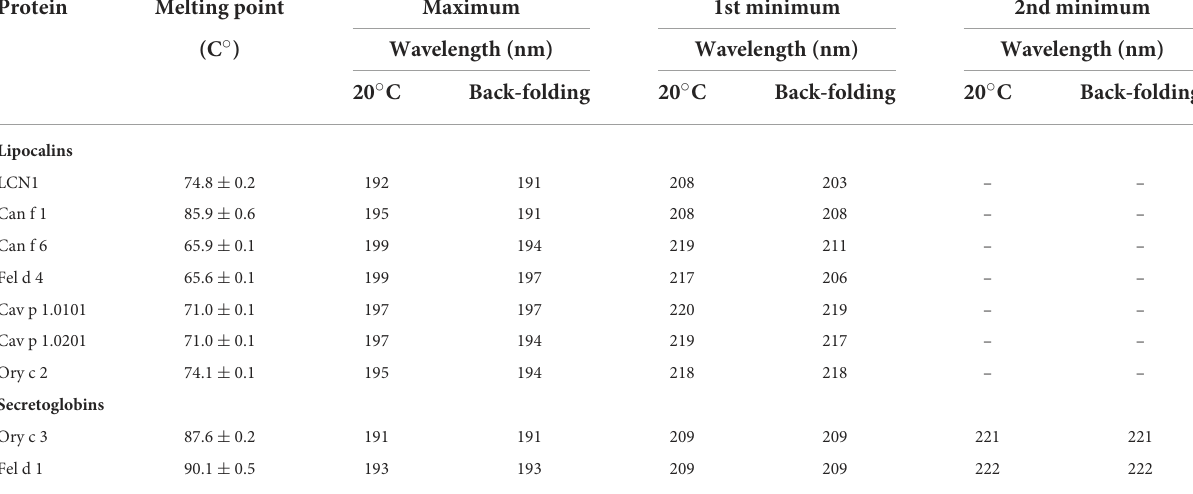
other allergens (Figure 4A). 1-AMA was chosen for the guinea pig lipocalin Cav p 1 isoallergens, rabbit lipocalin Ory c 2, and rabbit secretoglobin Ory c 3. Fluorescence intensities increased 20–60-fold upon binding. While the emission maxima shifted from 565 to 485 nm for lipocalin fluorochrome-allergen pairs, the blue shift was less pronounced for the Ory c 3 secretoglobin- 1-AMA complex to 505nm (Figure 4B). Interestingly, the cat derived major allergen Fel d 1, belonging to the same protein family of secretoglobins, only showed negligible